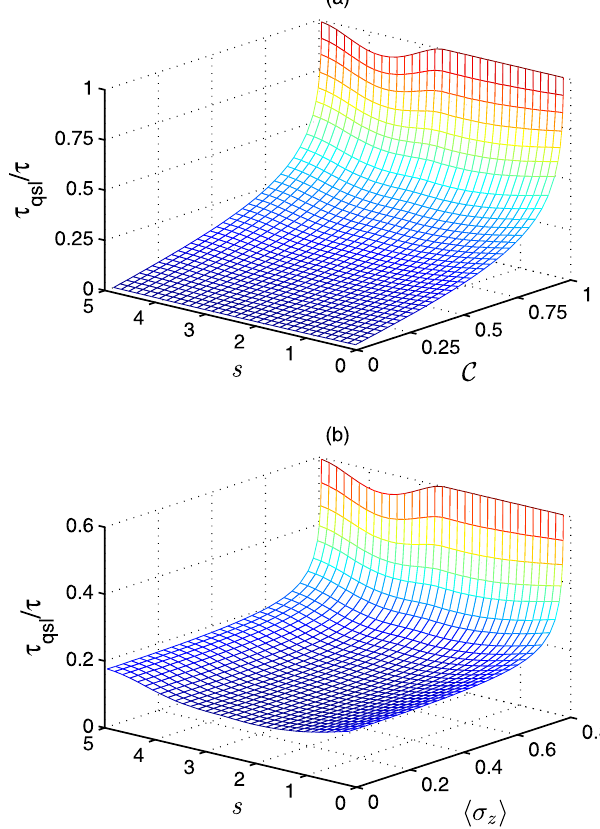
Figure 2. The ratio between quantum speed limit time and actual driven time τ qsl / τ for the dephasing model. ( a ) The ratio τ qsl / τ is the functions of the Ohmic parameter s and the coherence of initial state  . The σ chosen as zero. ( b ) The ratio τ qsl / τ varies as with the Ohmic parameter s and ⟨ ⟩ σ 0 6  = . . In both the panels (a,b), the actual driven time are chosen as constant τ =